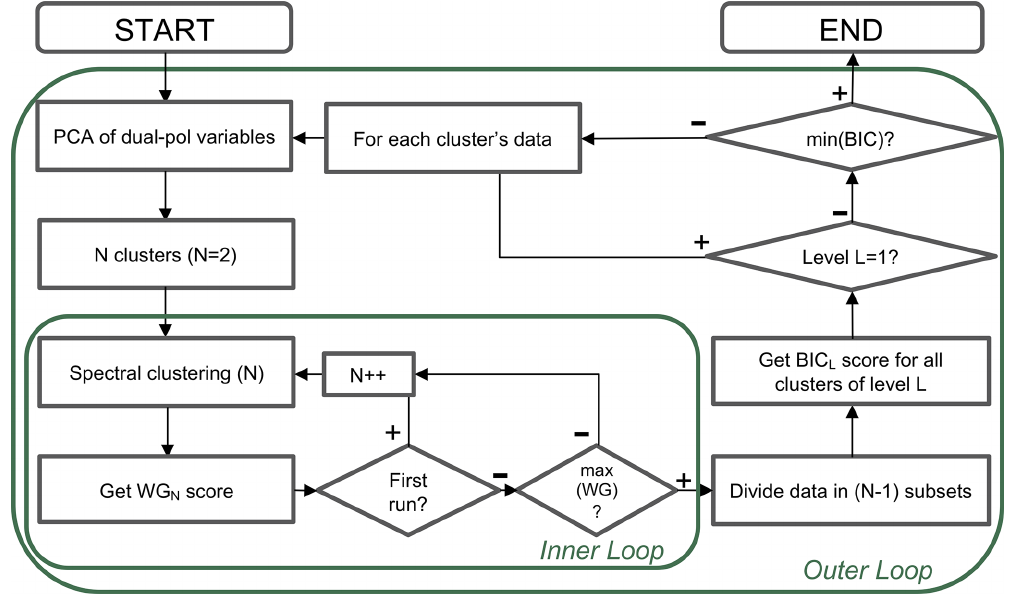
Figure 3. Flow chart of the implemented hierarchical top-down clustering